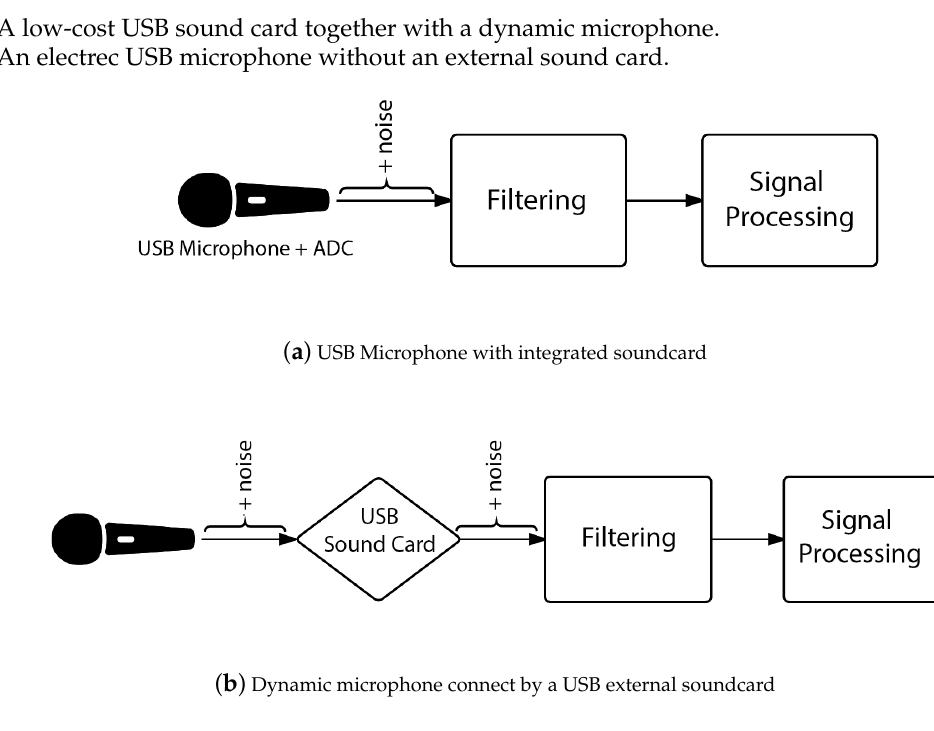
Figure 3. Different sound acquisition settings. ( a ) An electrec USB microphone without an external sound card; ( b ) Low-cost USB sound card with a dynamic